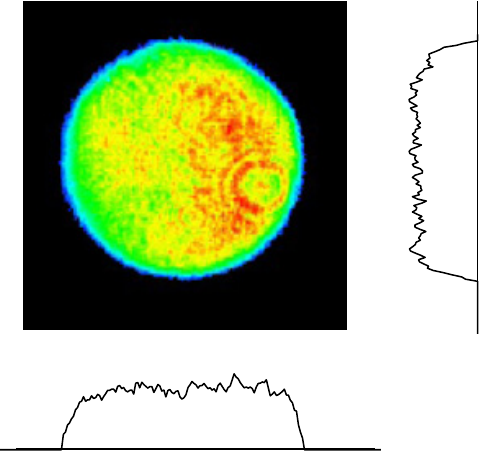
Figure 8. Near-field spatial intensity distribution of the final amplifier